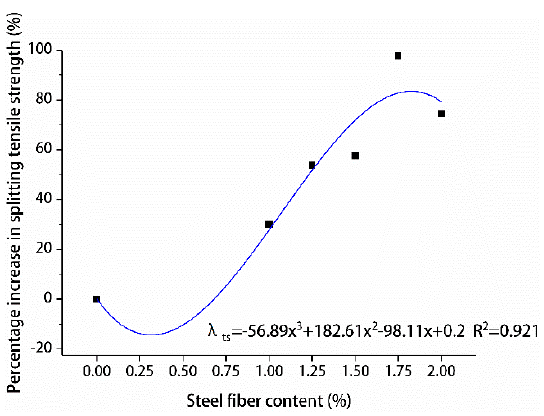
Figure 25. Relationship between splitting tensile strength and steel fiber content.